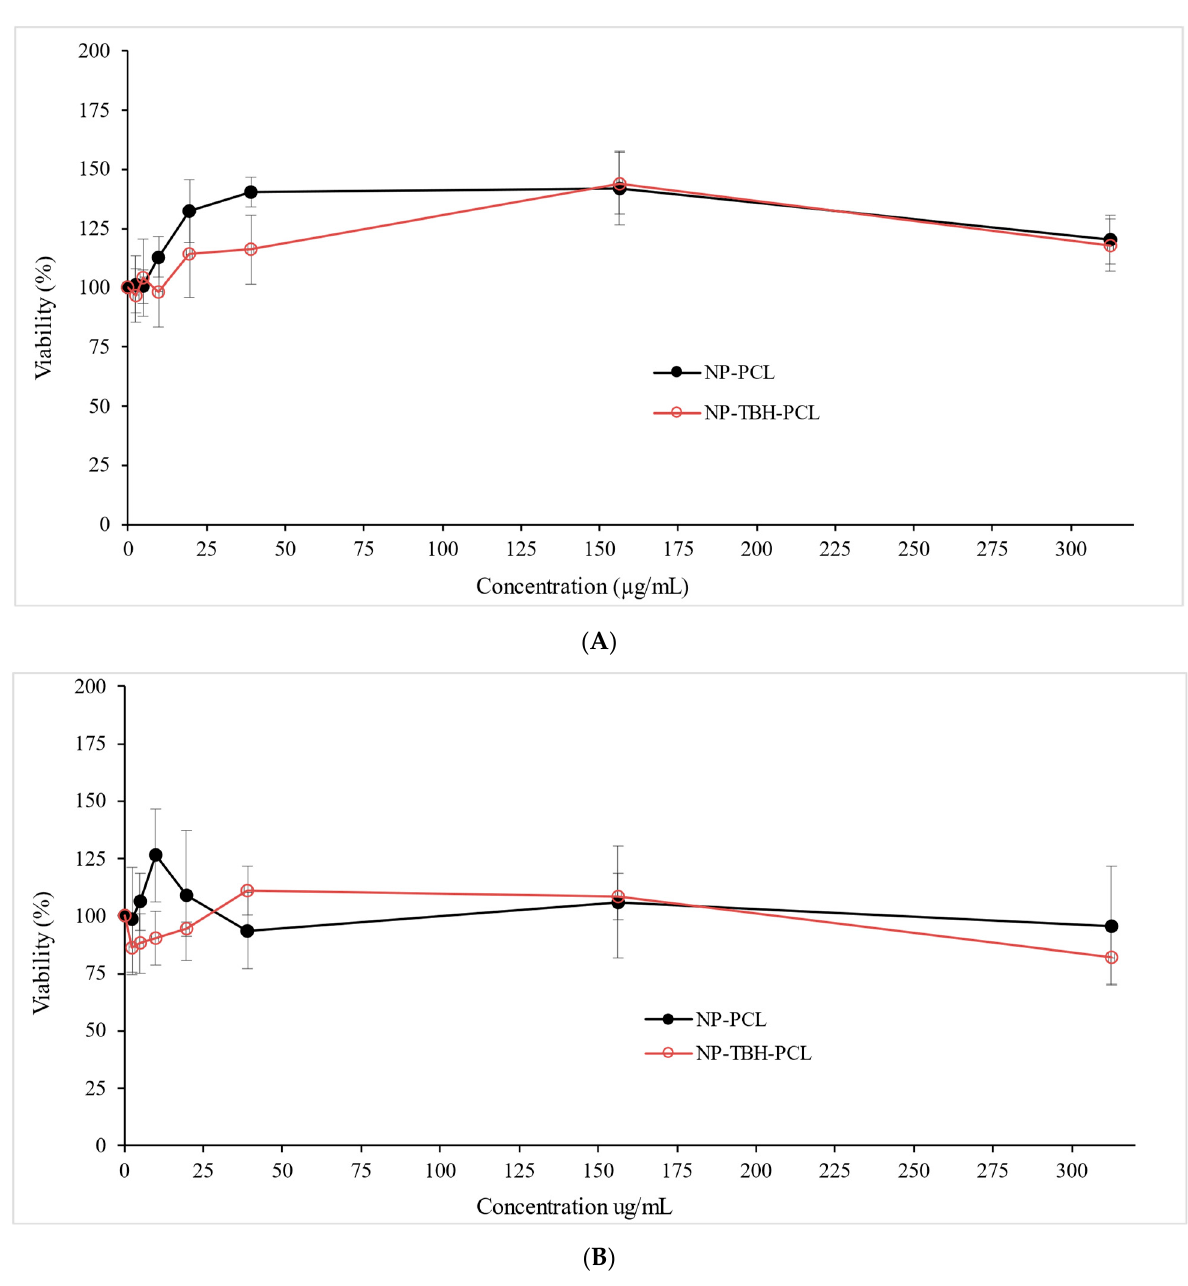
Figure 5. Viability after 24 h ( A ) and after 48 h ( B ) of NP-PCL and NP-TBH-PCL. Data are presented as average ± SD, n = 4).